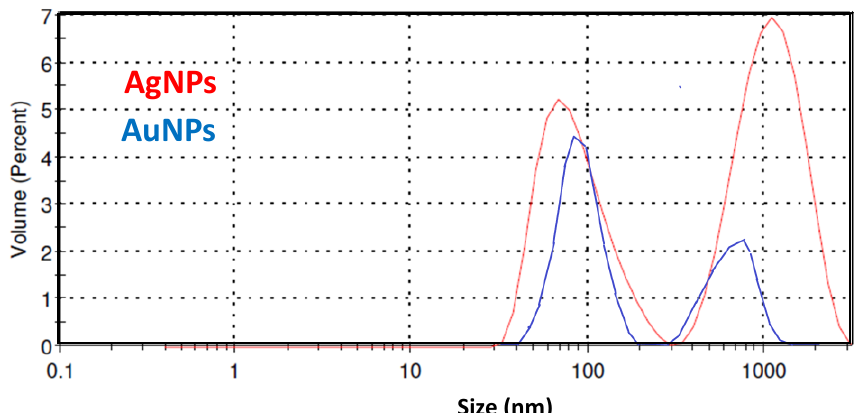
Figure 3. Dynamic light scattering (DLS) pattern for AgNPs and AuNPs.